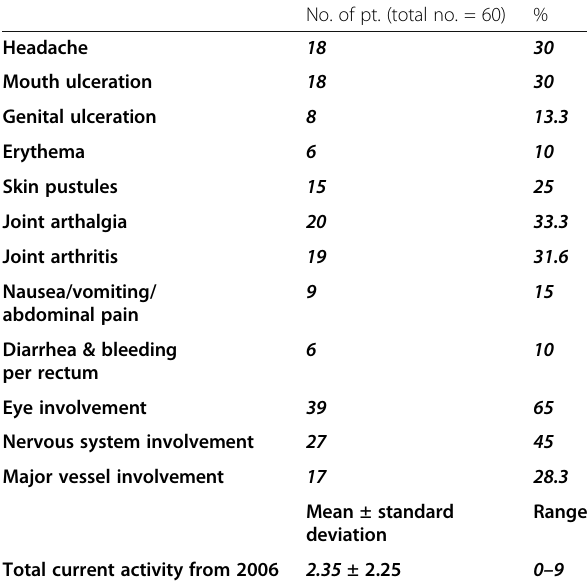
Table 4 Results of BDCAF in the studied BD patients No. of pt. (total no. = 60)